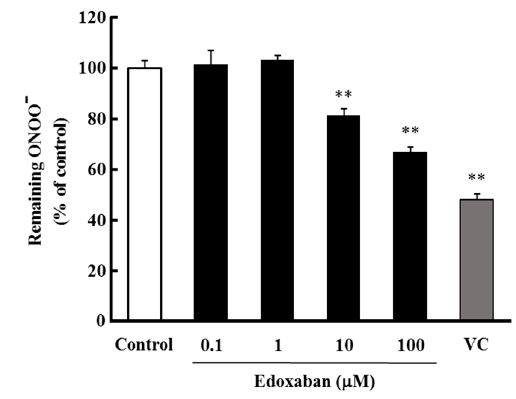
Figure 4. Effect of edoxaban on peroxynitrite (ONOO − ) scavenging activity by dihydrorhodamine123 studies. Quantitation of ONOO − remaining. Values are expressed as the mean ± S.D. ( n = 4). ** p < 0.01 vs. control. VC: Vitamin C.